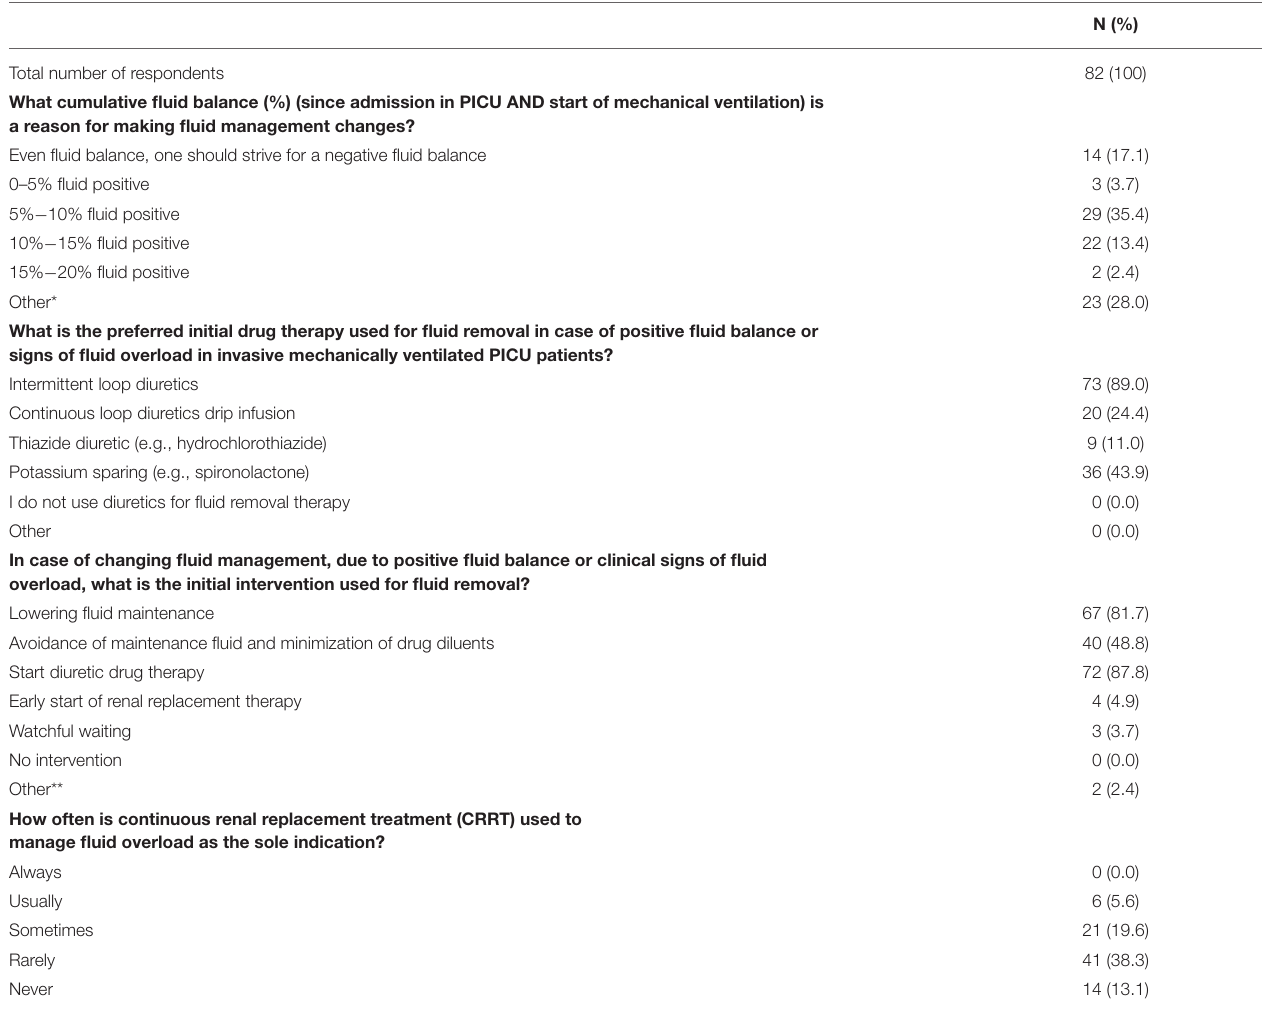
TABLE 4 | Fluid balance and indication of fluid removal